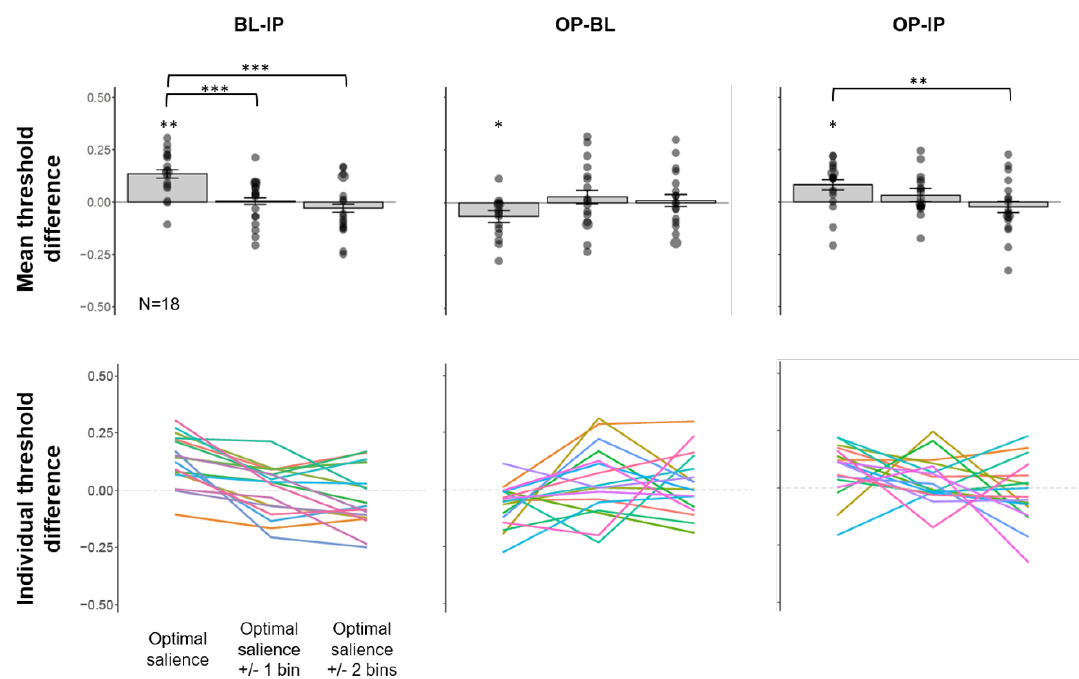
Figure 6. (Top panel) Mean threshold difference (+/- SE) and (bottom panel) trends line for individual participants across three comparisons aligned to the individual observers’ optimal salience bins. ***: p < 0.001, **: p < 0.01, *: p < 0.05.